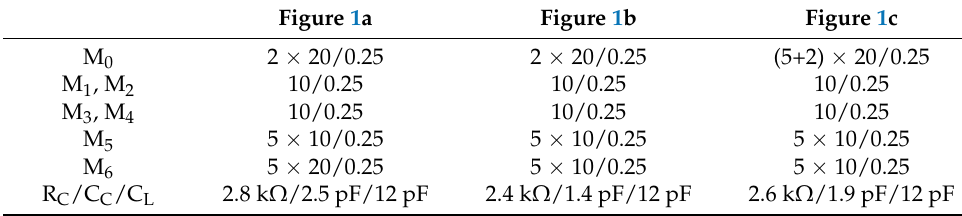
Table 1. Transistors sizes (W/L in µ m/ µ m) and values of R C and C C